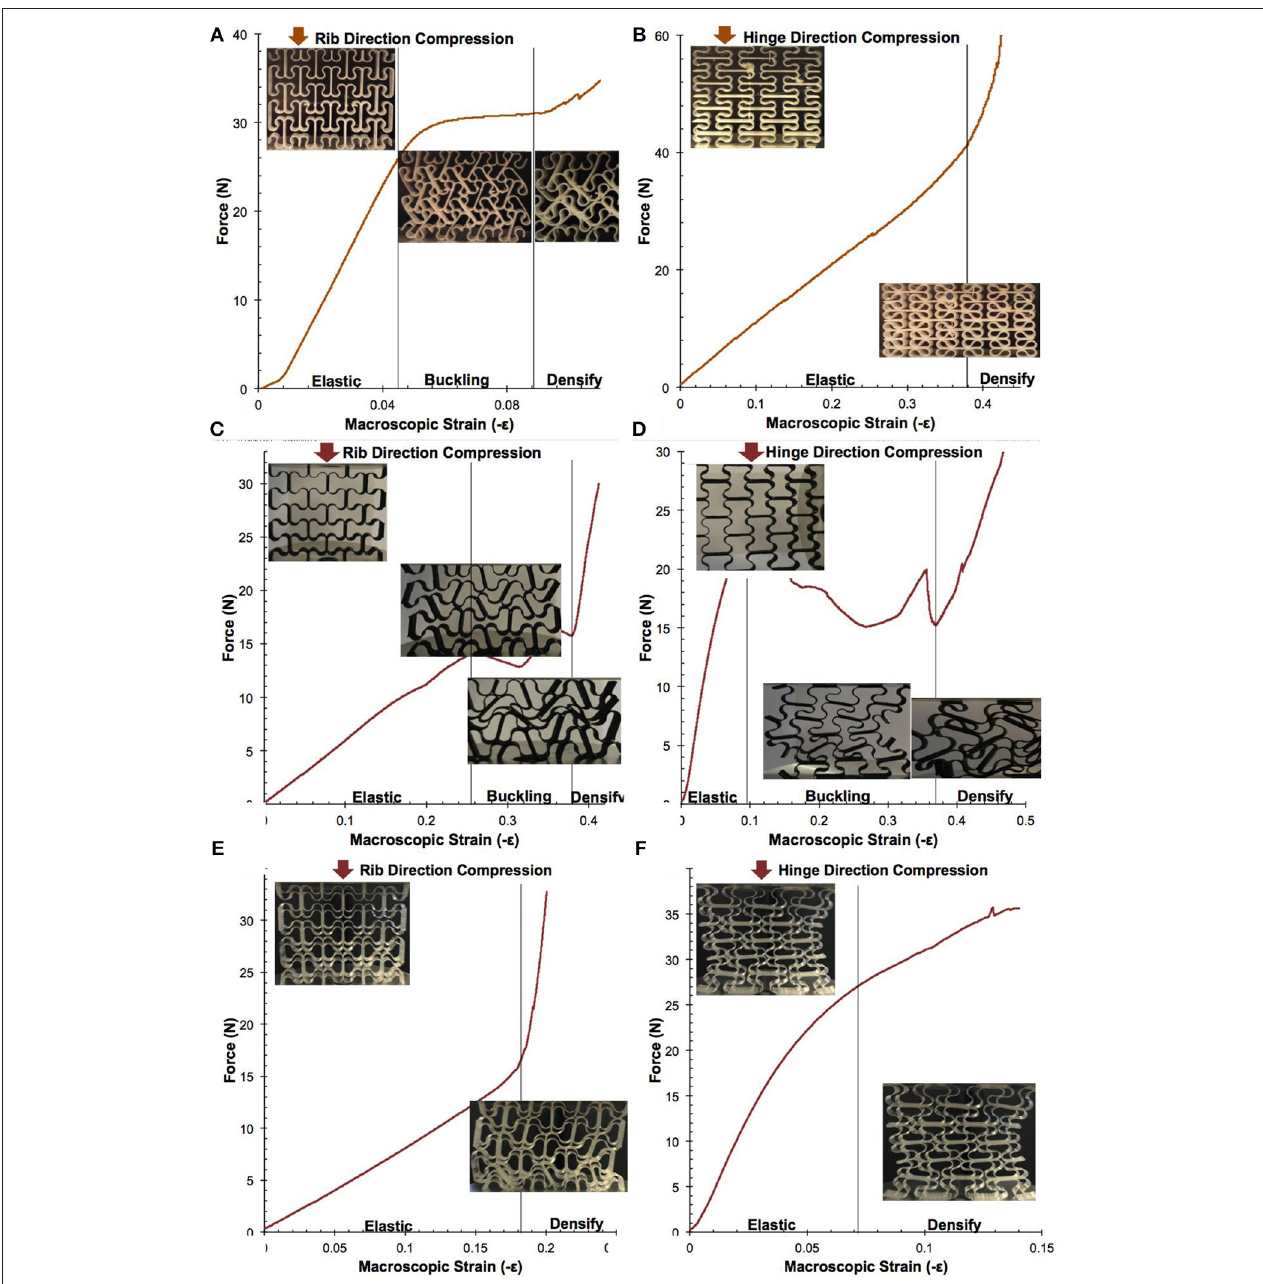
FIGURE 3 | Force-displacement characterization of s-hinged auxetic deformed in the rigid rib and hinged directions. For the s-hinged auxetic, (A) compression along the rigid rib direction results in a linear region up to 5% strain, then an in-plane buckling / slipping of unit rows in opposite directions, and finally densification after contacting neighboring elements, and (B) compression along the hinge direction results in a nearly-linear behavior. The 160-degree single s-hinge structure compressed in the (C) rib and (D) hinge direction experiences an elastic, buckling, and densification region. The double s-hinge structure compressed in the (E) rib direction and (F) hinge direction, transitions directly from the linear deformation region to the high stress region where elements come in contact, eliminating the in-plane (nonmonotonic) buckling region observed in the single s-hinge structure.